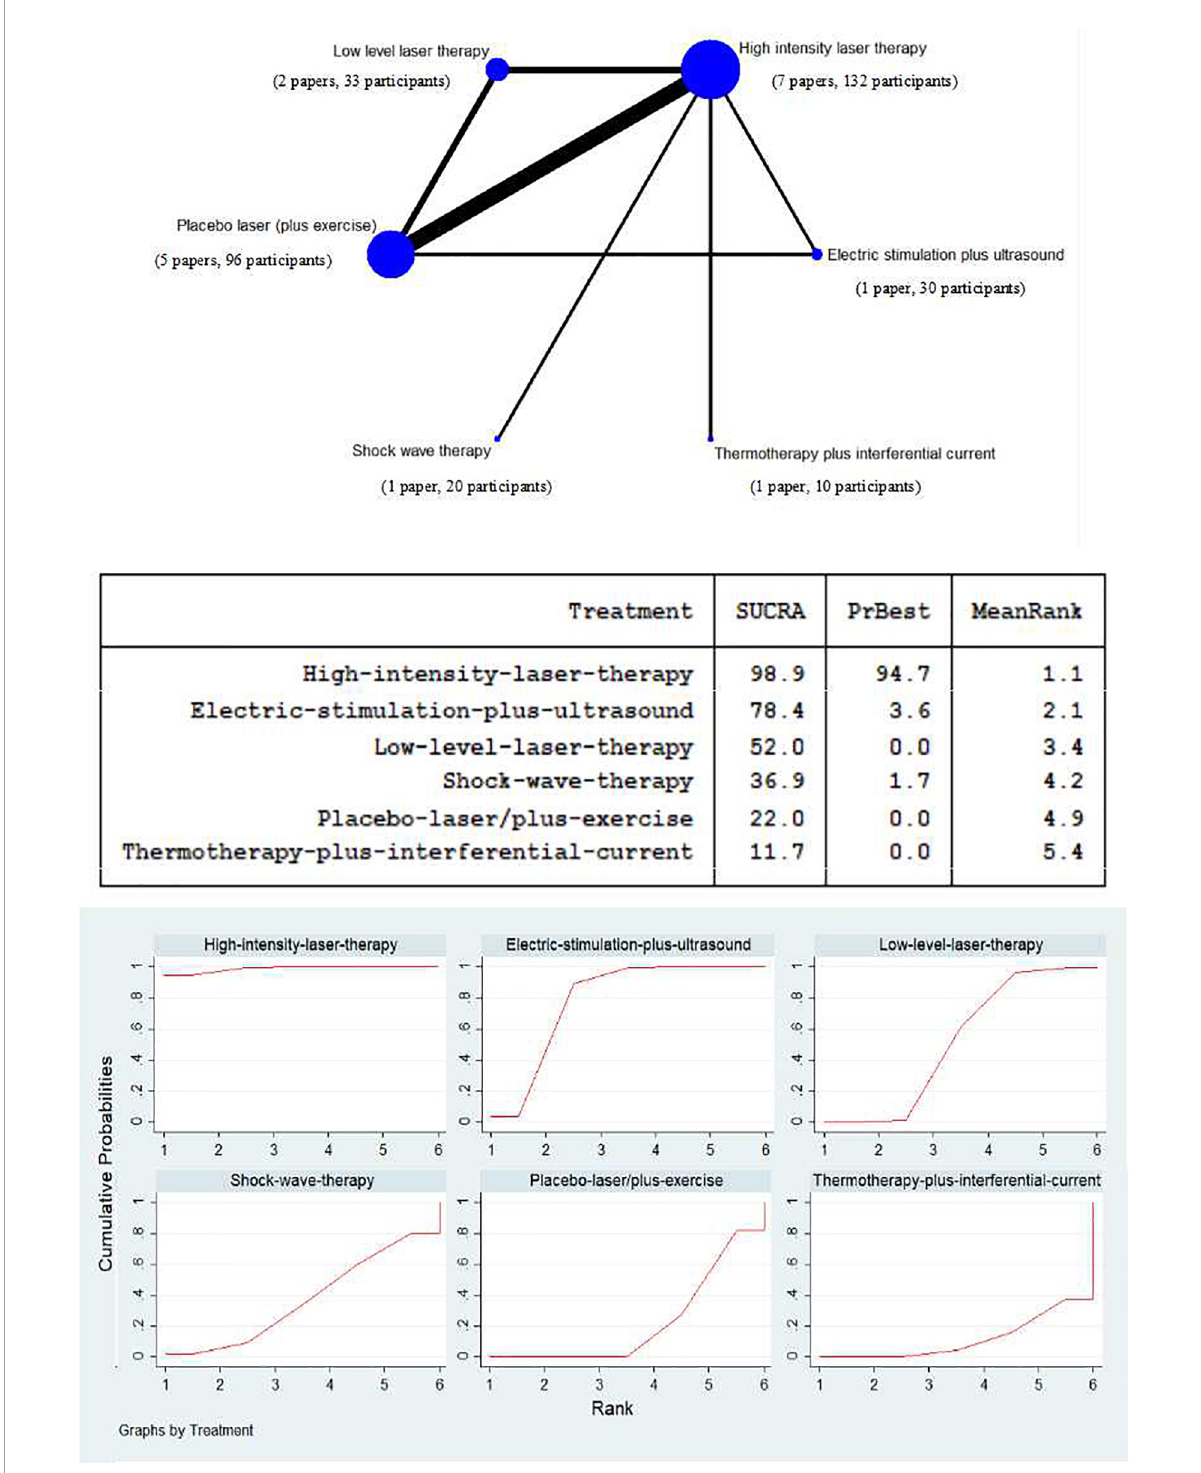
FIGURE6 Network meta-analysis plot for the assessment of high intensity laser therapy (HILT) and other physical therapy modalities (nodes are weighted in accordance with the number of trials including the respective treatments. The larger the size of node and the thicker the lines are, the more studies are involved). Treatment relative ranking (the PrBest means the estimated probability that the treatment is the best one. The lower the value of Mean Rank is, the higher the efficacy of the treatment may be. The ranking probability plot for the assessment of improved WOMAC total at the end of the physical therapy modalities is